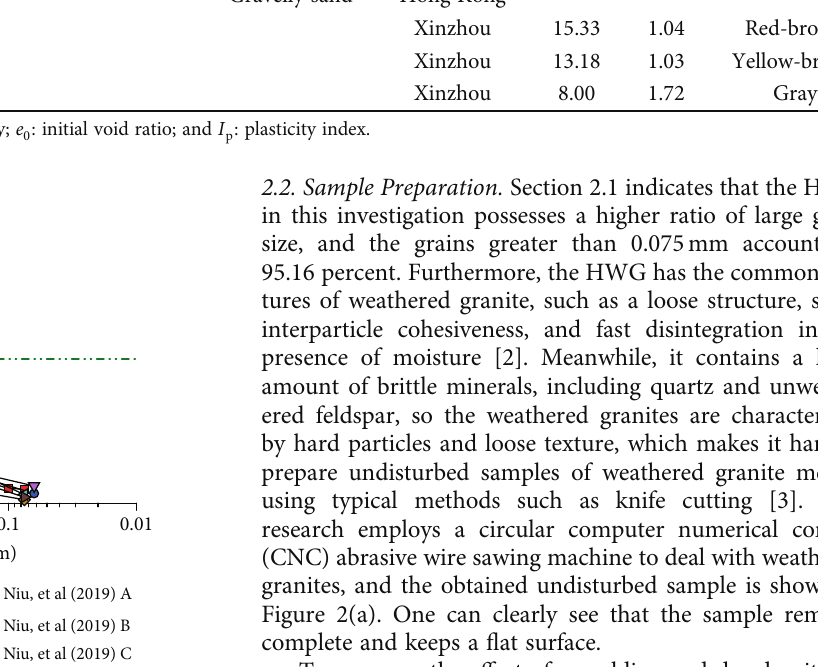
Figure 1: GSD of weathered granites (citation from Lee and Coop [19], Ng et al. [20], and Niu et al.